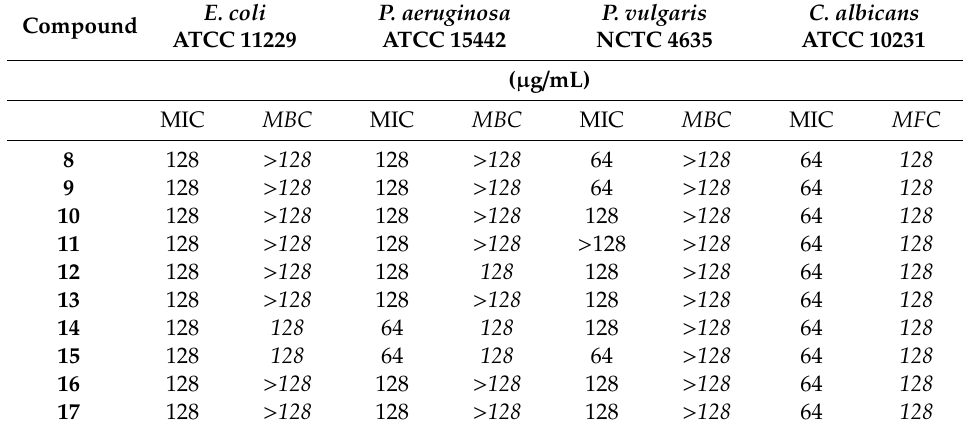
Table 2. Minimal inhibitory concentration (MIC) and minimal bactericidal concentration (MBC) of 8 – 17 against Gram-negative reference bacteria and minimal fungicidal concentration against Candida albicans .